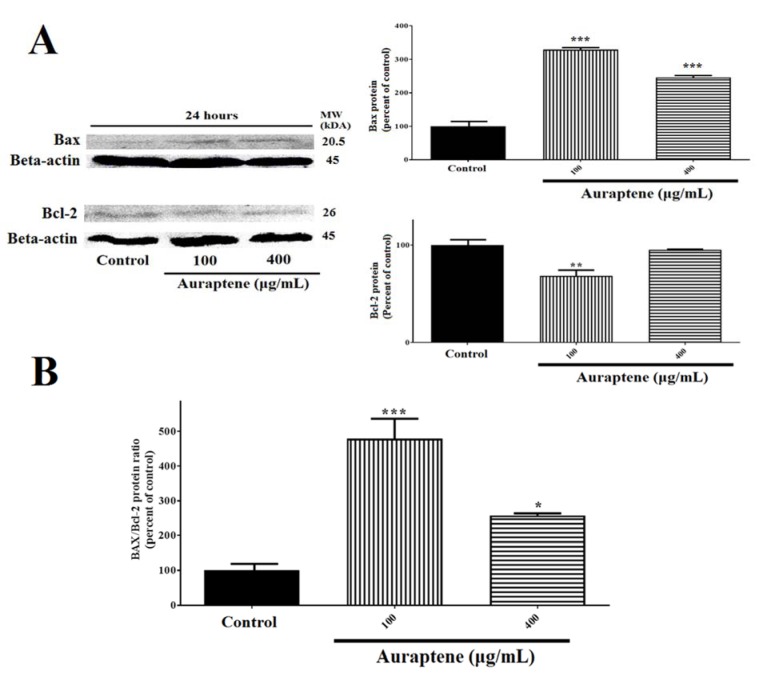
(A) Auraptene suppresses Bcl-2 protein expression in U87 cells and up-regulates Bax protein level. U87 cells were treated with 100 and 400 μg/mL of auraptene for 24 hours. The total protein levels of Bax and Bcl-2 are assessed by Western blotting. The relative density of Bax and Bcl-2 are determined by densitometry of the blots using Image J 1.52a software and were compared to the β-actin protein. **p<0.01 and ***P<0.001 compared to the control group. (B) Auraptene increased the Bax/Bcl-2 protein ratio after 24 hours' treatment, significantly. *p<0.05 and ***P<0.001 compared to the control group